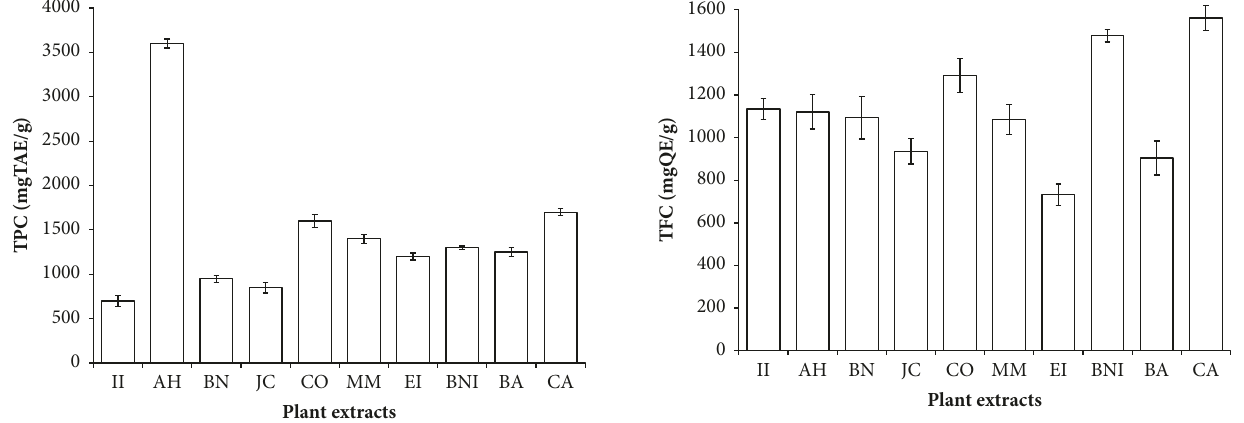
Figure 1: The total phenolic content (TPC) of selected plants used in the management of oral and skin infections in southeast Nigeria.